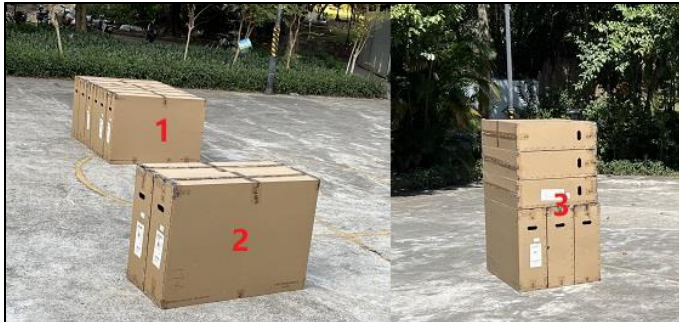
Figure 6. Three box groups used to train the M3C2 model.